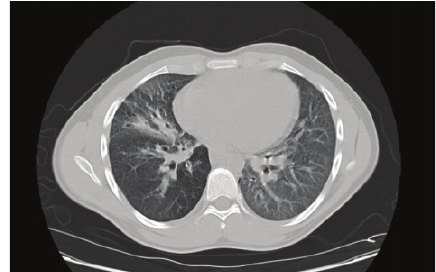
Figure 1: CT scan of the chest showing central